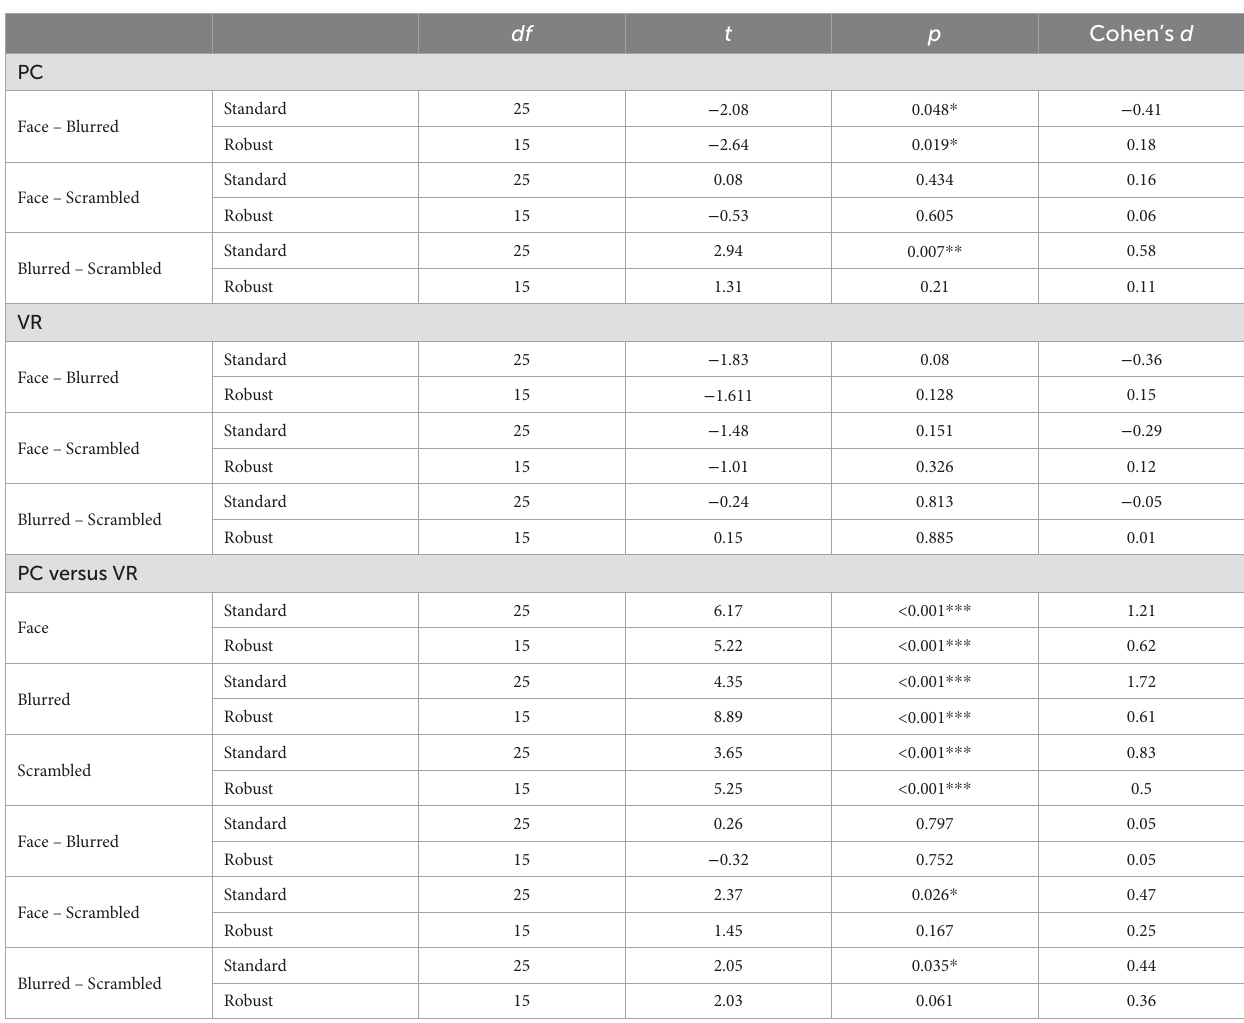
TABLE 3 Pairwise comparisons of N170 amplitudes within and between